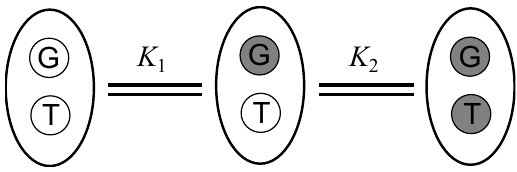
Scheme 1. Schematic representative model for the binding reactions of organometallic ruthenium anticancer complexes to oligodeoxynucleotides (ODNs) I and IV – IX at the guanine (G) and thymine (T) sites based on the divalent receptor system. Bare circle with G/T means unoccupied site and black circle with G/T means occupied site.